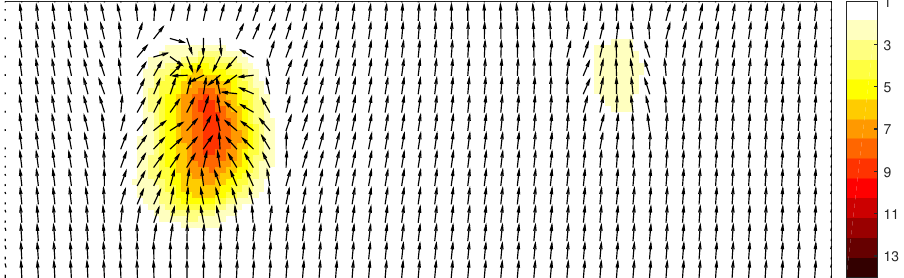
Figure 8. Spatial distribution of total variance (in m 2 ) and vector plot of mean wave direction obtained with scheme